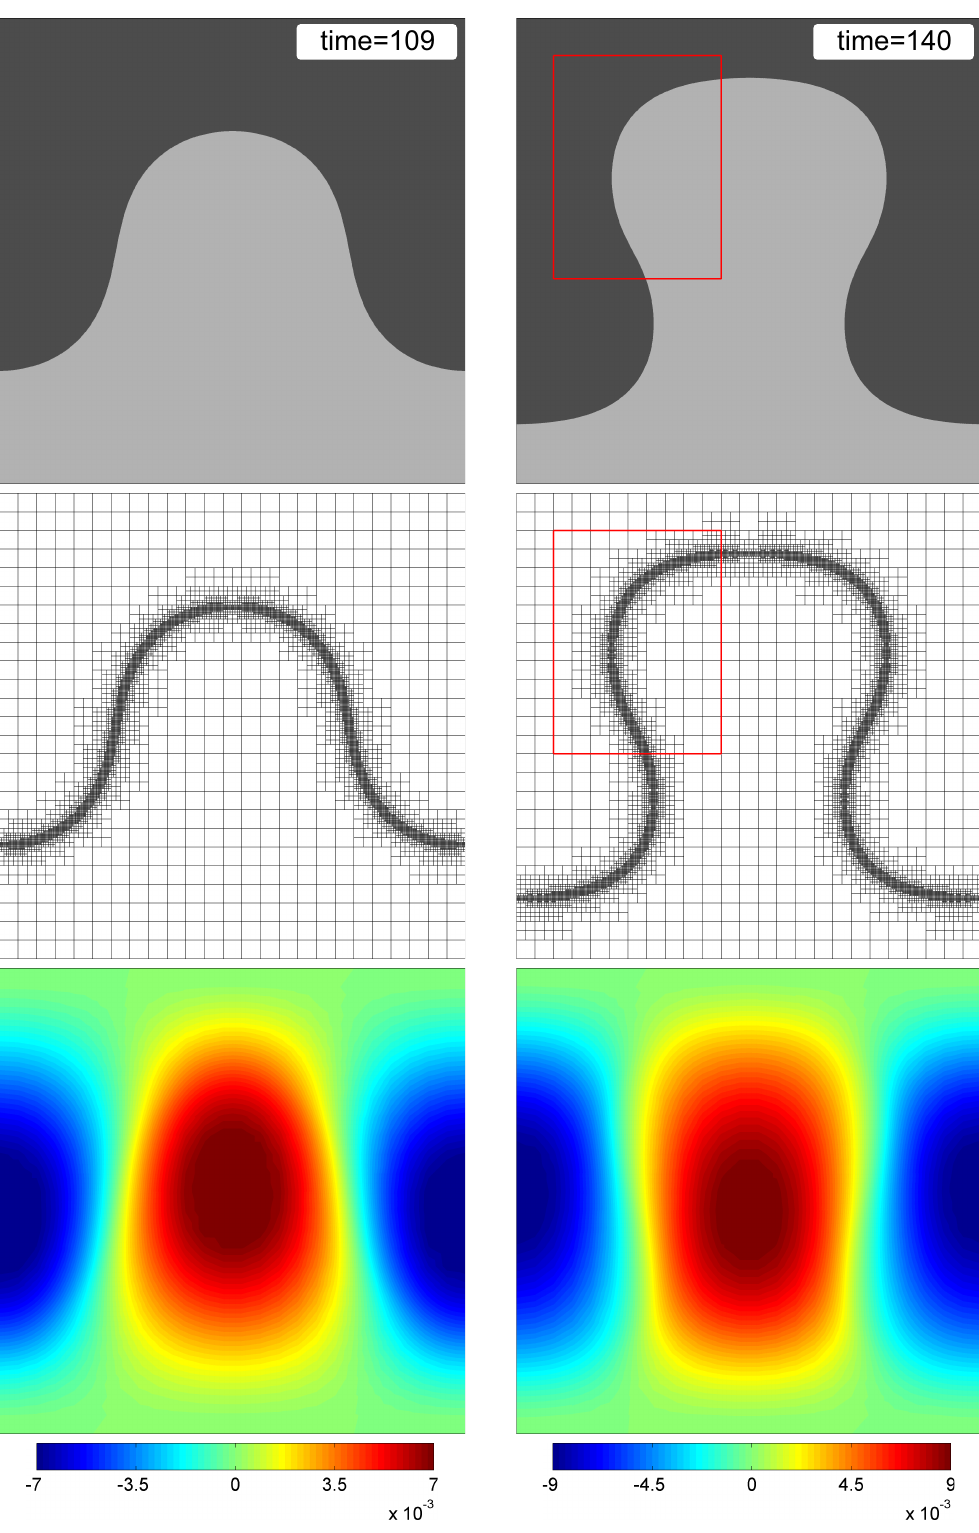
= 1. top : material plot; middle : η 2